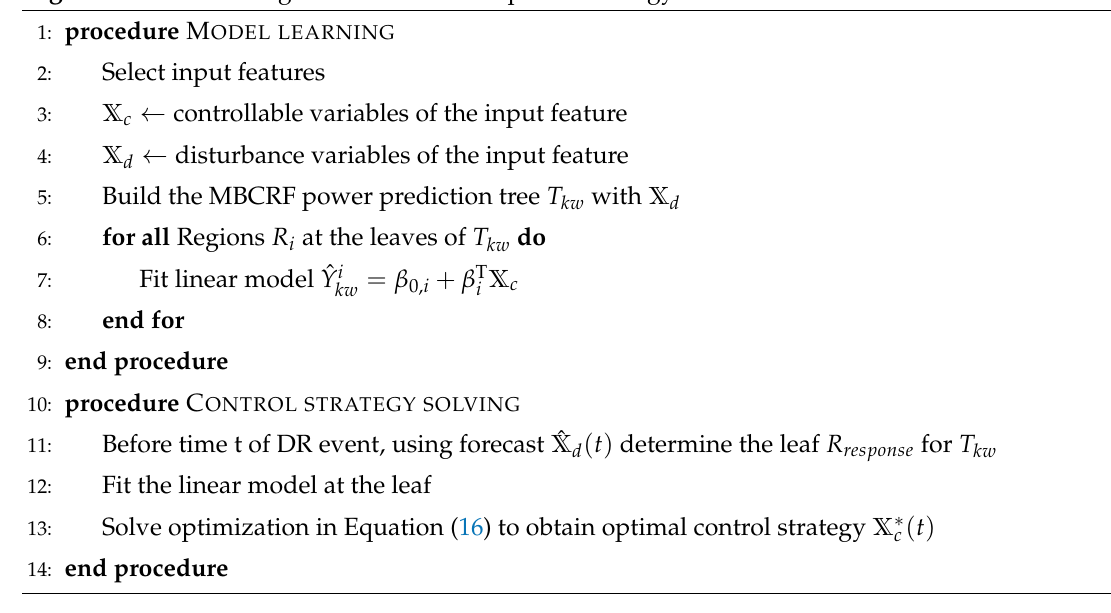
Algorithm 1 MBCRF algorithm for the DR optimal